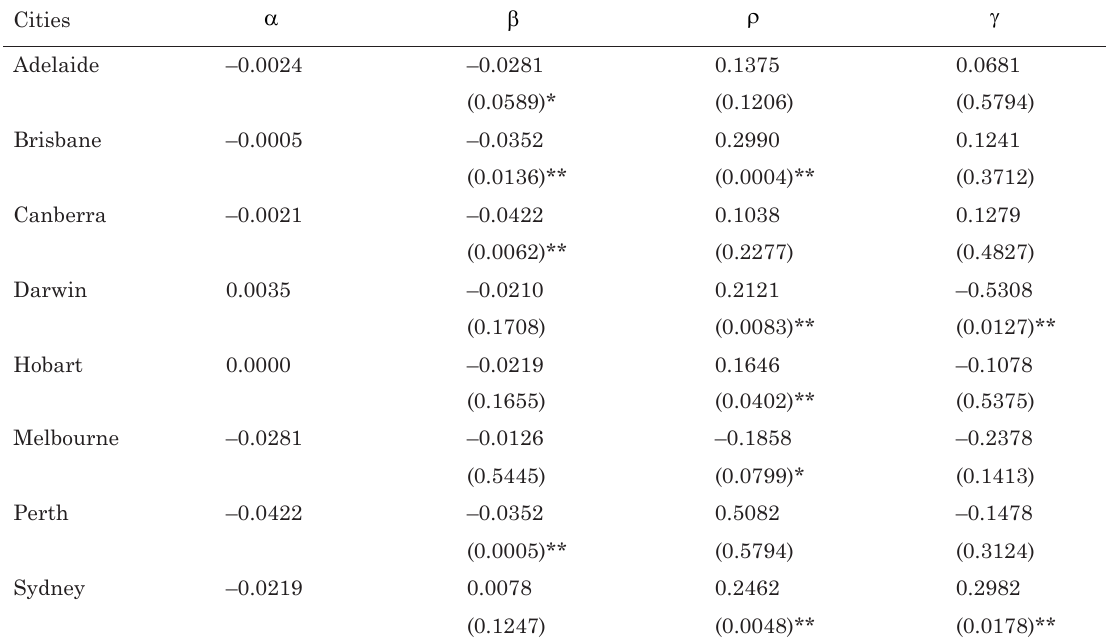
Table 4. Estimates of the spatio-temporal convergence model